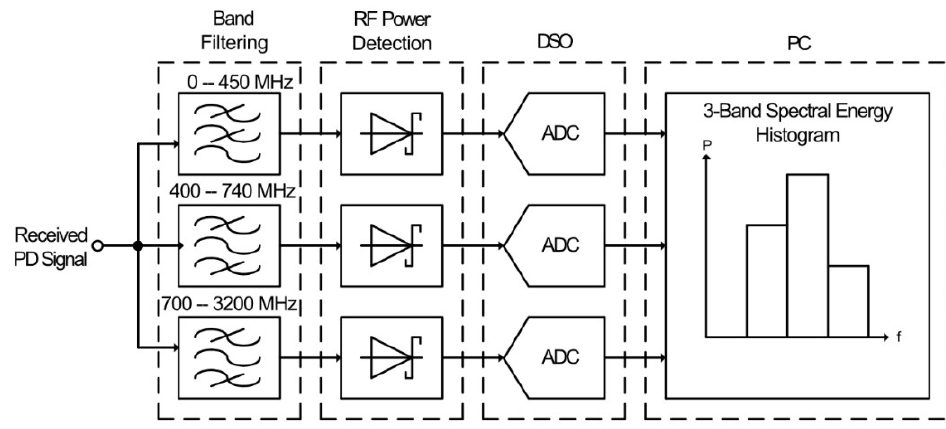
Figure 6. A frequency-based RF PD sensor [59].